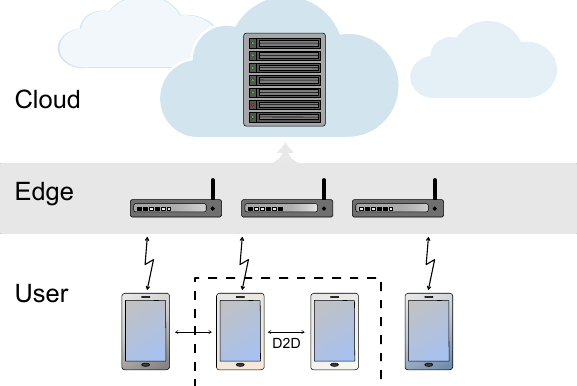
Figure 5. Example of the architecture involving proximity-based D2D communications in an Edge/Cloud